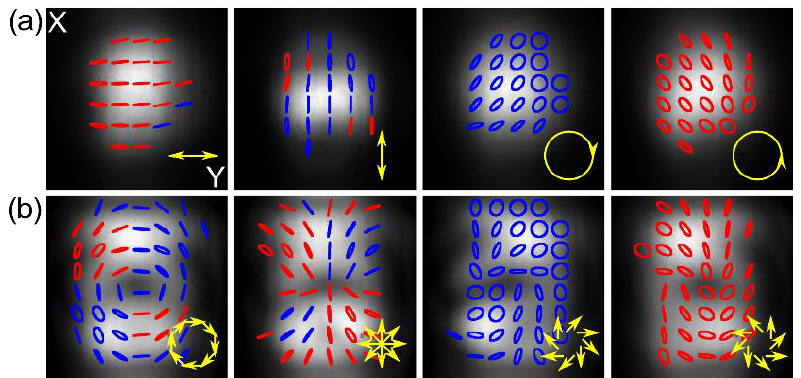
Figure 3. The experimental results of converting the y -polarized Gaussian beam using NLC-PC into ( a ) uniform and ( b ) cylindrically symmetric SOP. Blue and red represent right- and left-handedness, respectively, and yellow arrows show the desired output SOP achieved by applying proper U 1 , U 2 , and U 3 voltages, as summarized in Table 1.